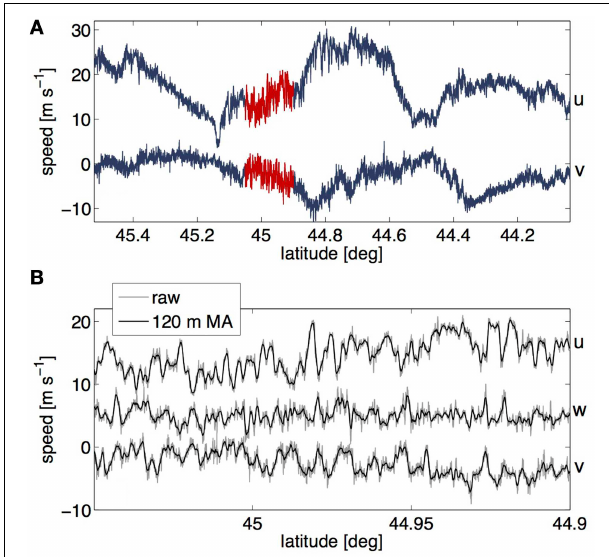
FIGURE 2 | (A) Raw u and v components of the wind velocity along the lower ABL flight leg (370m ASL) over the Adriatic. The segment chosen for the analysis of possible rolls (44.90–45.05 ◦ N) is shown in red. (B) The three wind components over the analyzed segment; shown are the raw and 120-m moving-average smoothed data. A 5m s − 1 offset has been added to w for presentation